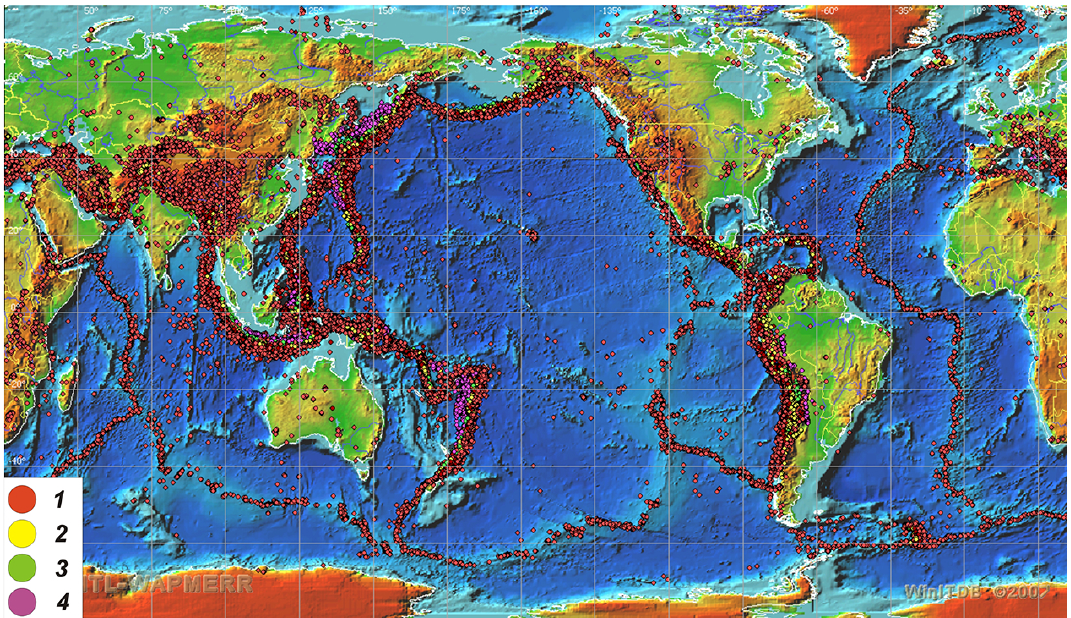
Fig. 1. The distribution of the EQ occurring since 1980 with M > 4 on the world map (data from ISC catalog). The epicenters are marked by color circles: 1 for 0 ≤ H ≤ 70, 2 for 70 < H ≤ 200, 3 for 200 < H ≤ 400, and 4 for 400 < H ; H is a hypocenter depth